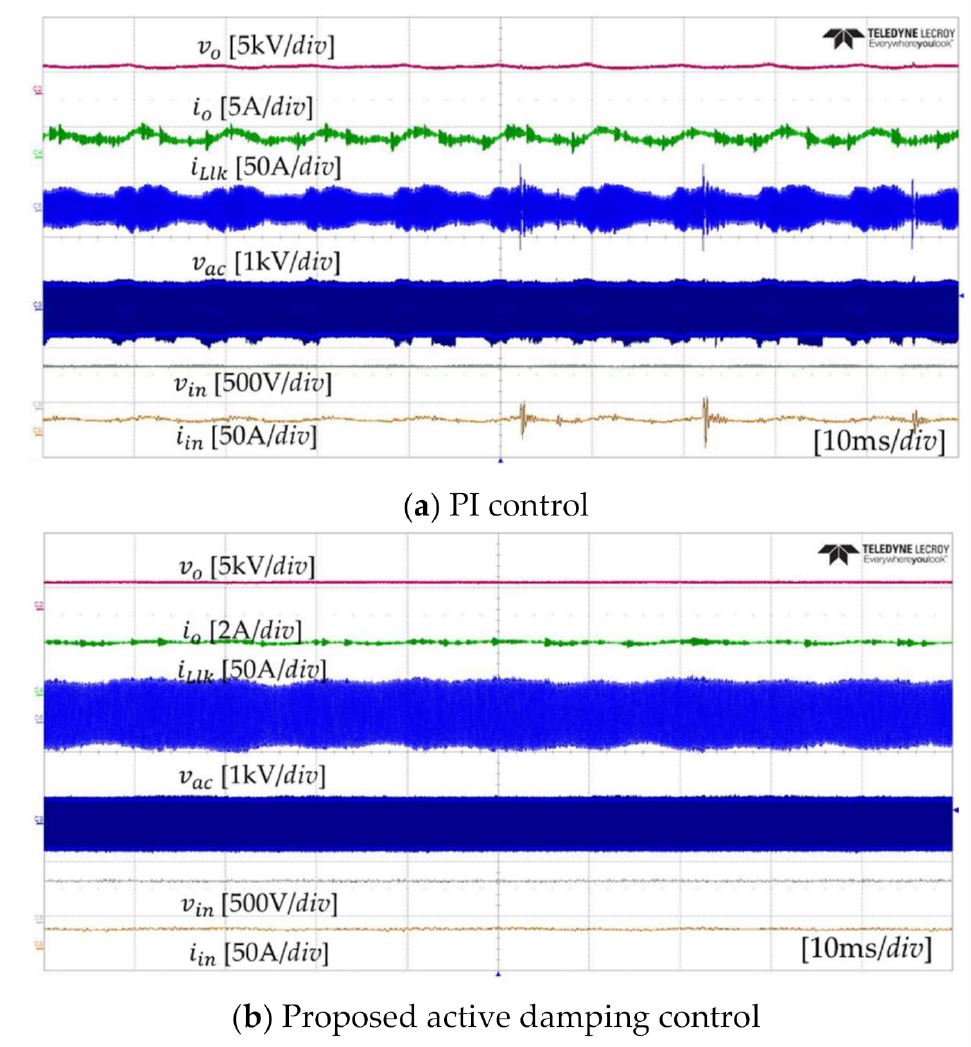
Figure 25. Experimental result of PI and proposed active damping control.